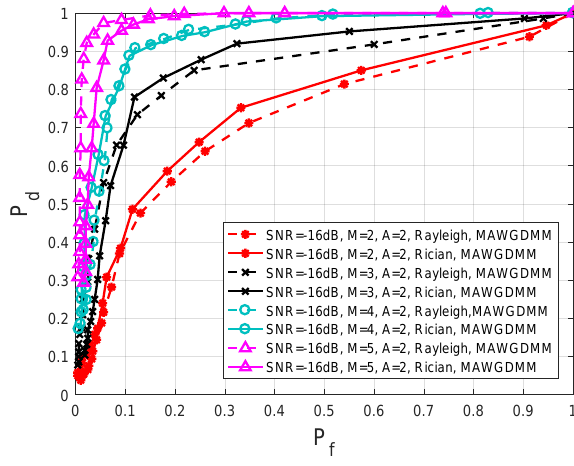
Figure 9. Comparison of ROC in different number of